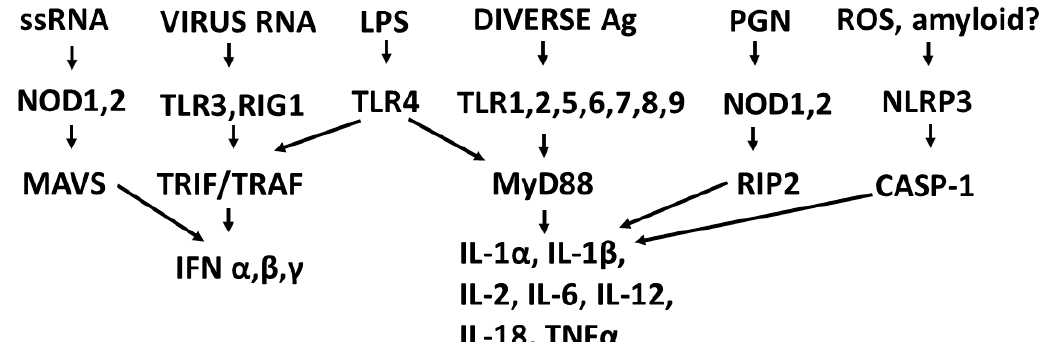
Figure 1. Outline of some of the main signaling pathways leading to cytokine release. RNA = ribonucleic acid; ss = single-stranded; LPS = lipopolysaccharide; Ag = antigens; PGN = peptidoglycans; ROS = reactive oxygen species; NOD = nucleotide-binding oligomerization domain-containing protein; TLR = Toll-like receptor; RIG1 = retinoic acid inducible gene protein-1; NLRP3 = NOD-, LRR- and pyrin domain-containing protein 3; MAVS = mitochondrial antiviral-signaling protein; TRIF = TIR domain-containing adapter-inducing interferon- β ; TRAF = TNF receptor-associated factor; MyD88 = myeloid differentiation primary response 88 protein; RIP2 = receptor-interacting- serine/threonine-protein kinase 2; CASP-1 = Caspase-1 or the interleukin-1 converting enzyme; IFN = interferon; IL = interleukin and TNF = tumor necrosis factor.